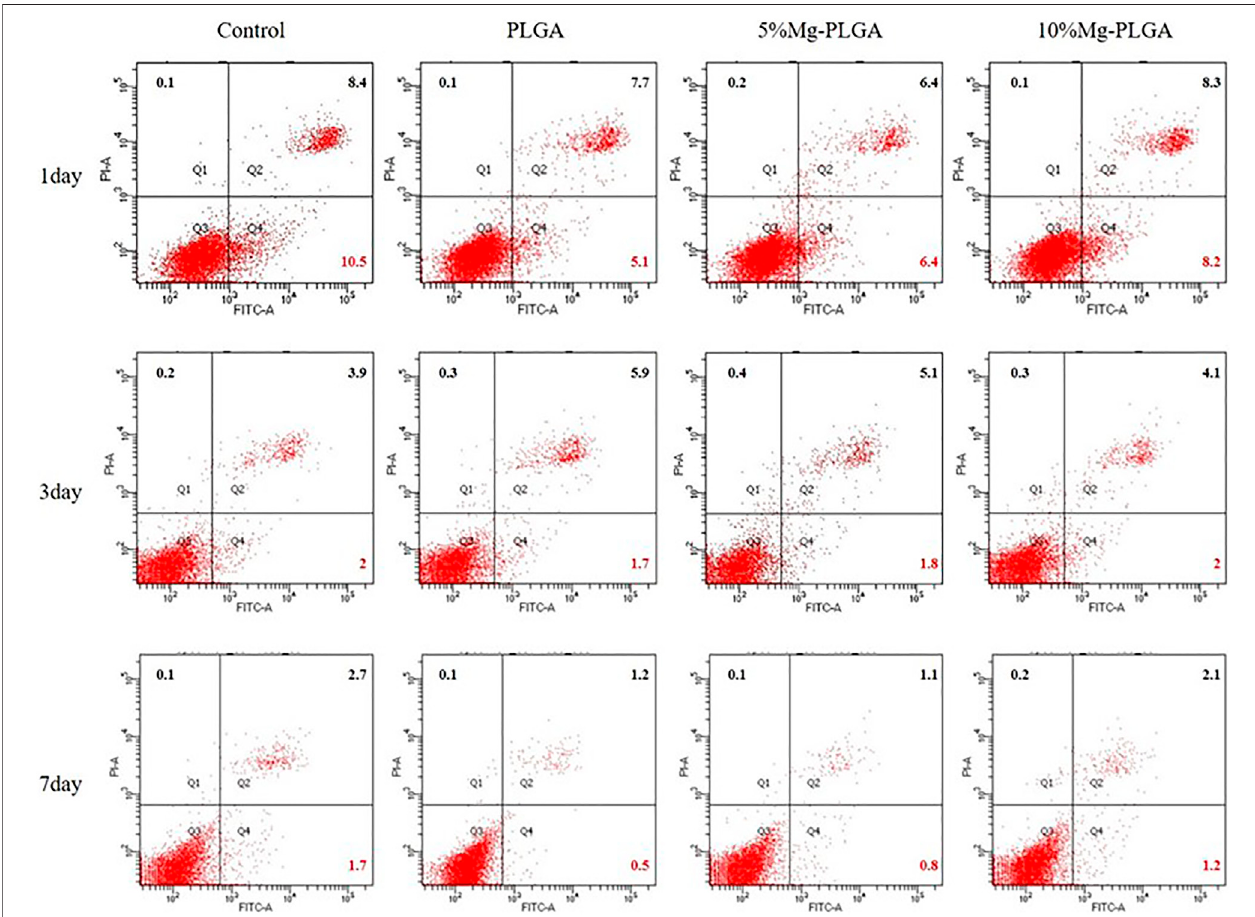
FIGURE5| TheapoptosisratesofMC3T3-E1cellscoculturedwiththesamplesfor1,3,and7 days.Earlyapoptotic,deadandlateapoptoticcellswerelocalizedin the lower right (Q4), upper left (Q1), and upper right (Q2) quadrant of a dot-plot graph respectively. It showed that with the increasing of the ratio of the magnesium, the early apoptosis rate of P5% Mg group and P10% Mg group increased correspondingly compared with P group at each time point, but lower than control group. The rates of the early apoptotic cells were basically proportional to the ratio of the magnesium.